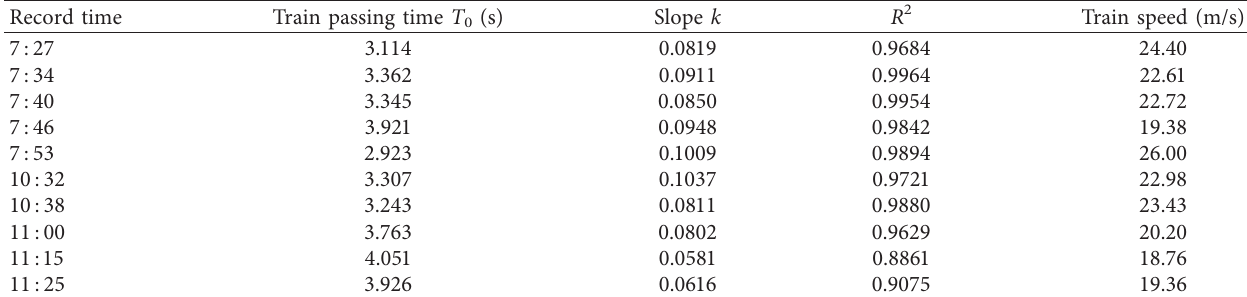
Table 4: Train passing time and train speed obtained by